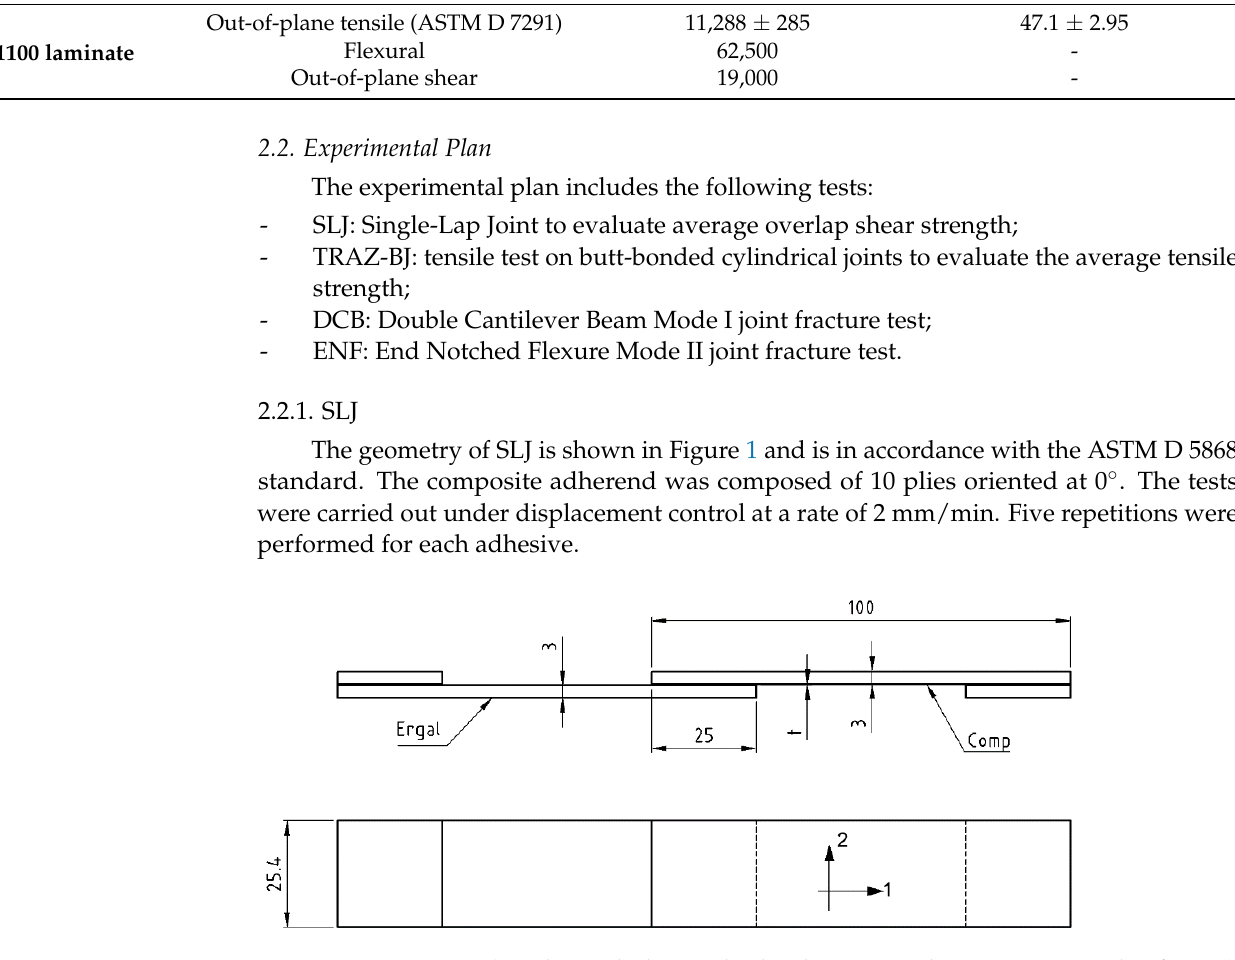
Figure 1. SLJ specimen (1 and 2 are the longitudinal and transverse direction, respectively, of T1100), t = 0.1 (AF 163) or 0.2 mm (9323). Dimensions are in mm.